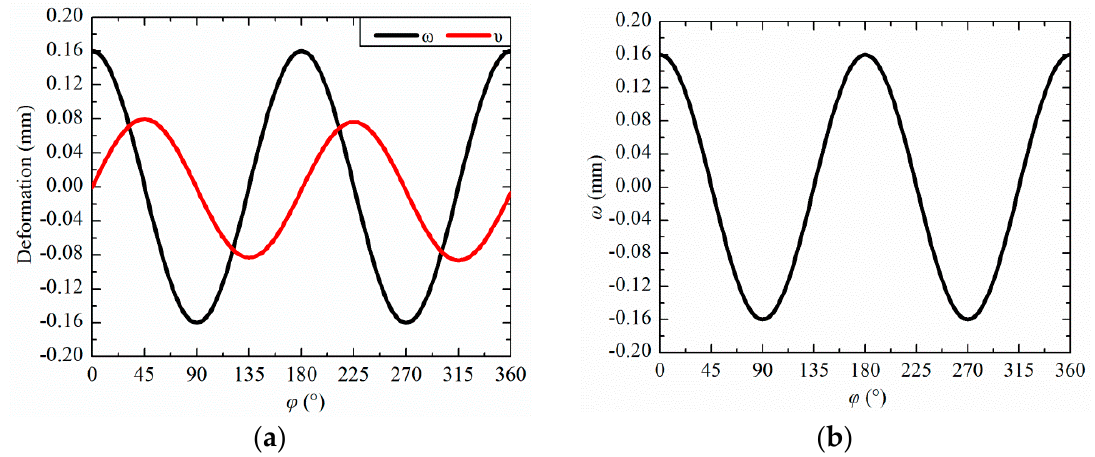
Figure 4. ( a ) The deformation of the conventional flexible wheel rim; ( b ) the deformation of the disposable flexible wheel rim.